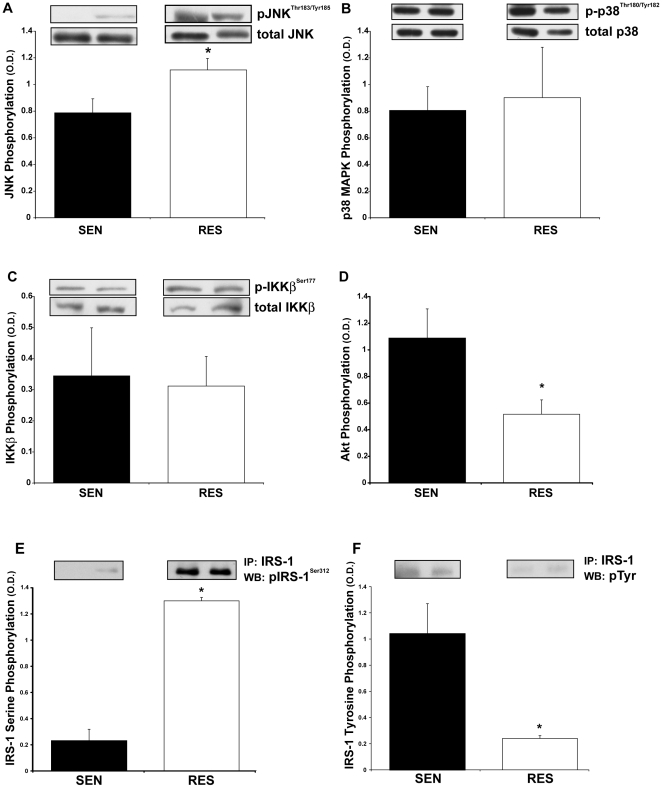
JNK activation in muscle from insulin resistant, non-obese subjects accompanies reduced insulin signaling and enhanced phosphorylation of IRS-1 on Serine312.Solubilized muscle biopsies obtained prior to insulin infusion were subject to SDS-PAGE, followed by Western blotting with phospho-specific antibodies against JNK Thr183/Tyr185 (A), p38 MAPK Thr180/Tyr182 (B), and IKKβ Ser177 (C). The predominant band (55 kD) recognized by the anti-JNK antibody is shown and was used for quantification. Optical density values were normalized to the content values for each protein as determined by Western blots for JNK, p38 MAPK and IKKβ, and are presented as mean ± SEM of the ratios of phospho- to total protein. *P<0.05 RES vs. SEN groups. (D) Muscle biopsies obtained after 2 hours of insulin infusion were solubilized and assayed for phosphorylation state of key second messengers of insulin signal transduction. Phosphorylation of Akt on Thr308 was determined by specific ELISA and normalized to total Akt content, also determined by ELISA. Values shown are mean ± SEM. *P<0.05, RES vs. SEN groups. Lysate volumes from insulin-stimulated muscle biopsies (4 SEN, 3 RES subjects) containing equivalent amounts of IRS-1 protein (as determined by ELISA) were immunoprecipitated with an antibody against IRS-1. Following SDS-PAGE, Western blotting was performed with a phospho-specific antibody against IRS-1 Ser312 (E), or with an anti-phosphotyrosine antibody (F). Blots were quantified by scanning densitometry and results expressed as mean ± SEM. *P<0.0005, RES vs. SEN groups.